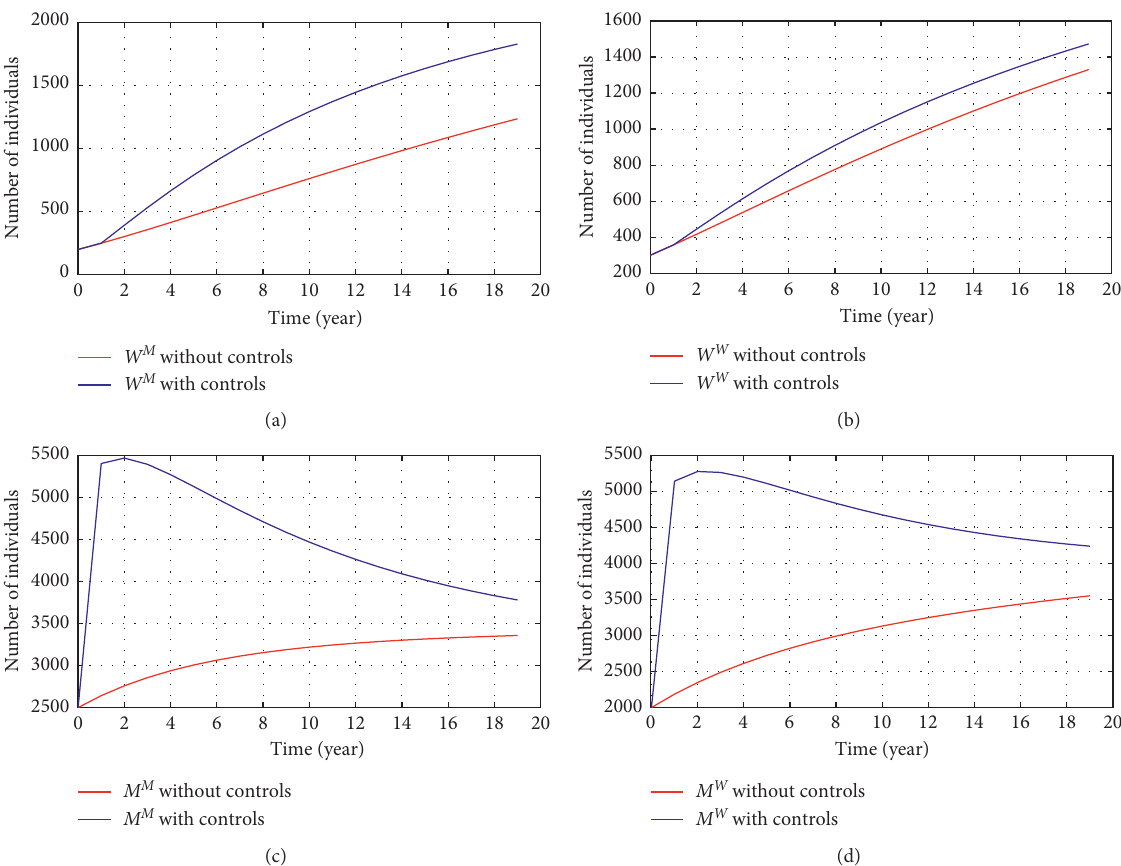
Figure 4: Time evolution of widowed and married populations with and without controls.